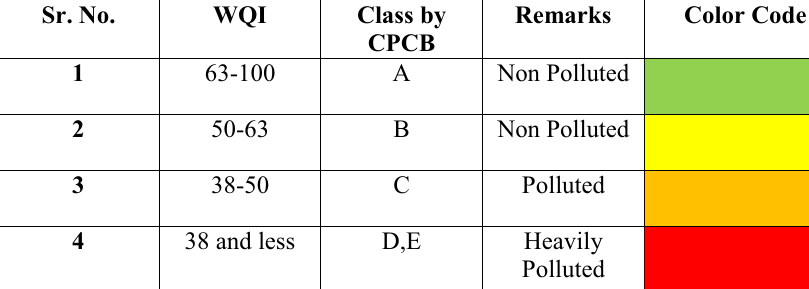
Table 3 Water quality classification and best designated use